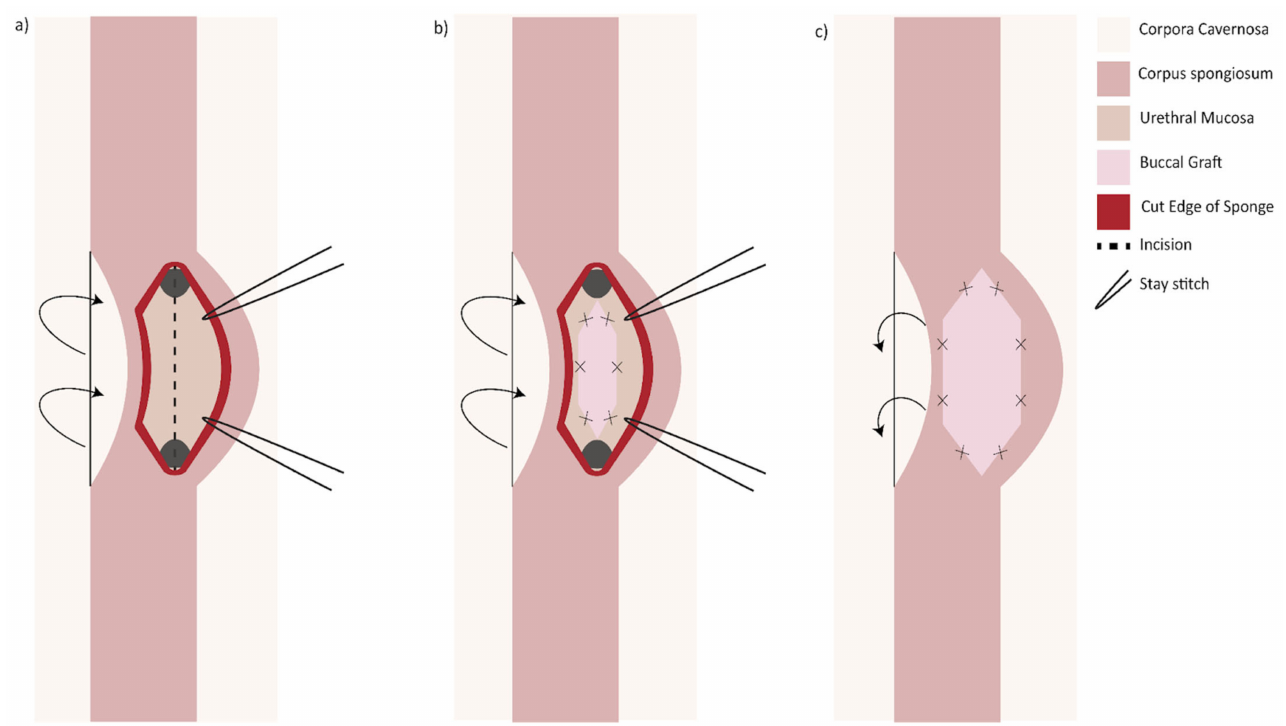
Figure 4. Double graft technique, dorsal approach: ( a ) the urethra is mobilized off the corpora and the dorsal surface is opened. An incision made in the ventral mucosa; ( b ) a buccal graft is sutured in the ventral defect; ( c ) the dorsal urethrotomy is closed with the aid of a second buccal mucosa graft. The urethra is tacked back into